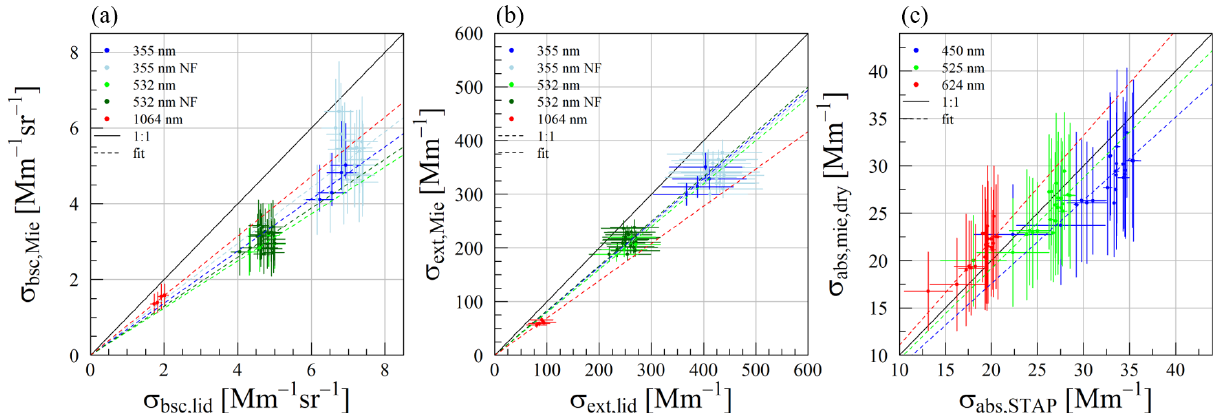
Figure 9. Optical coefficients derived with the Mie model (ambient for extinction a and backscattering b ; dry for absorption c ) based on the data from 9 February plotted against the coefficients derived with lidar and STAP, respectively. The black line indicates the 1 : 1 line, and colors represent the respective wavelengths. Horizontal error bars indicate the uncertainty range of the lidar estimates for backscattering and extinction; for measured absorption, they represent the standard deviation of the mean. Vertical error bars indicate 3 times the standard deviation of the mean in the case of the Mie